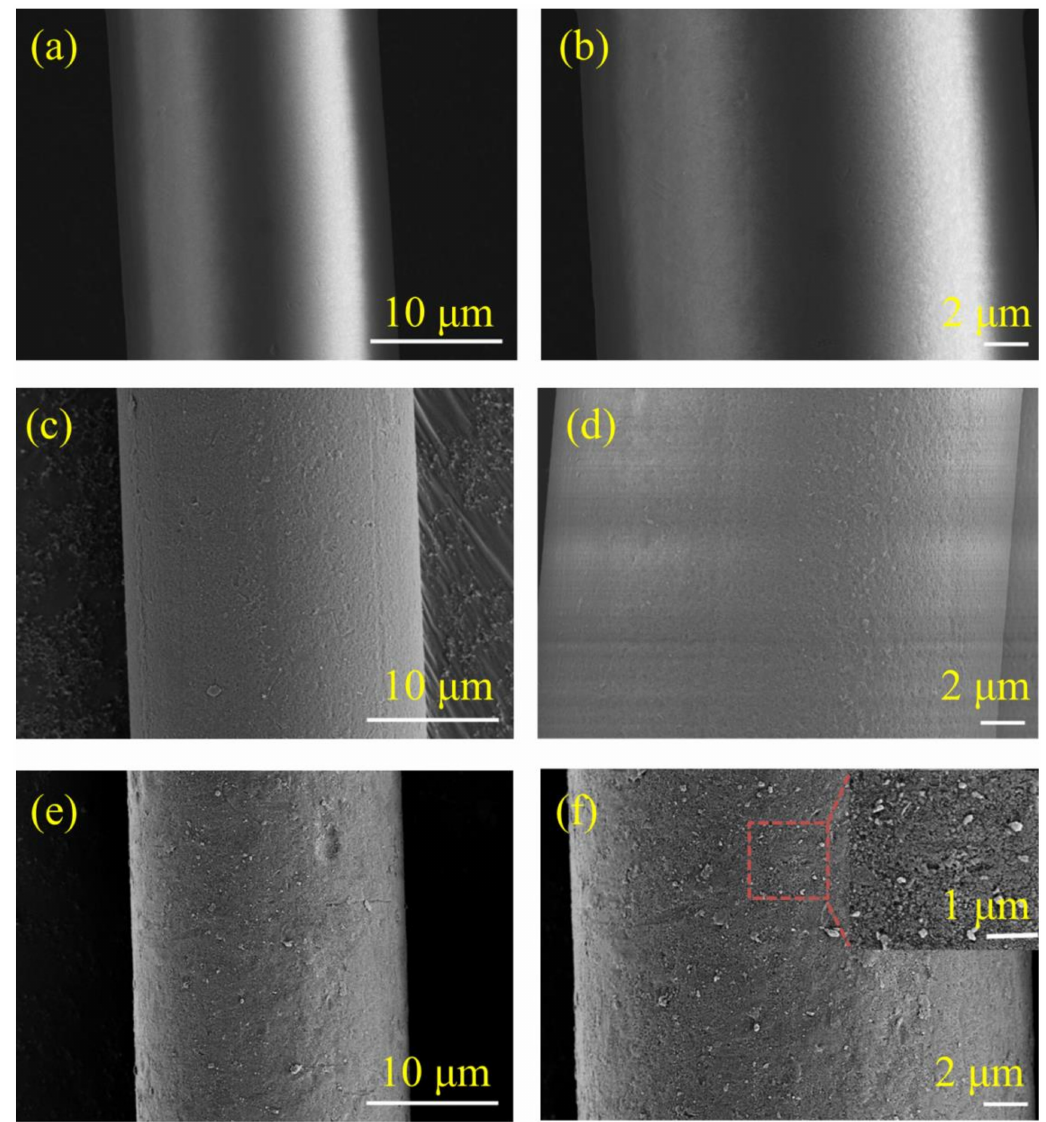
Figure 6. SEM images of PET filaments: ( a ) and ( b ) PF, ( c ) and ( d ) PF-1, ( e ) and ( f )